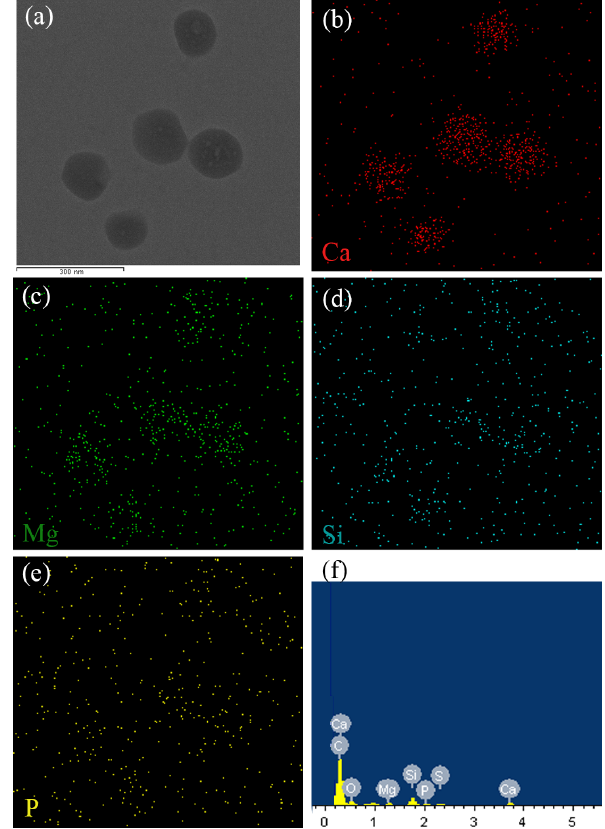
Figure 5. Chemical composition of ACC nanoparticles. (a) STEM images showing ACC nanoparticles. (b, c, d, e) XEDS maps of Ca, Mg, Si, and P, respectively, showing that ACC is composed mainly of Ca. An EDS spectrum of the nanoparticle shows a small peak of element P (f) . However, the P signal from the STEM mapping is not consistent with the nanoparticles (e)